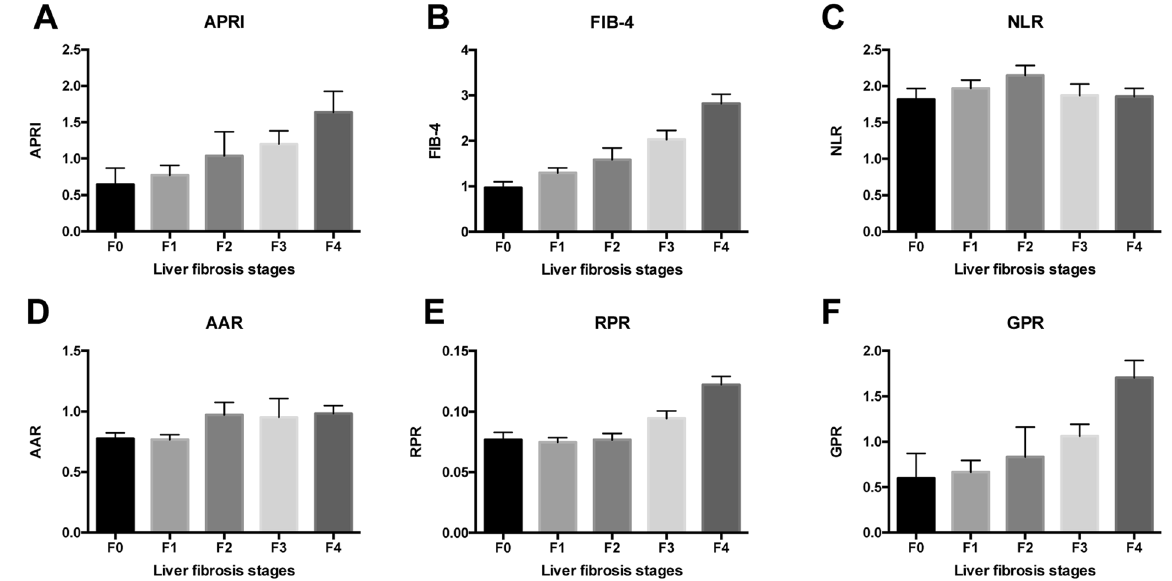
Figure 1. Comparisons of different NITs according to the fibrosis stages in CHB patients.